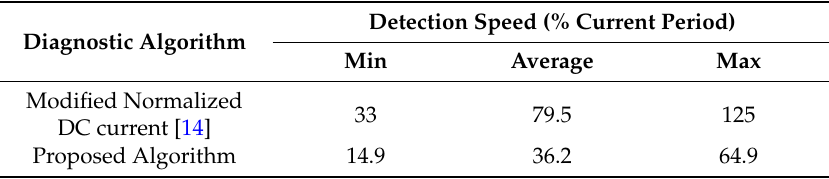
Table 3. Comparison of the detection